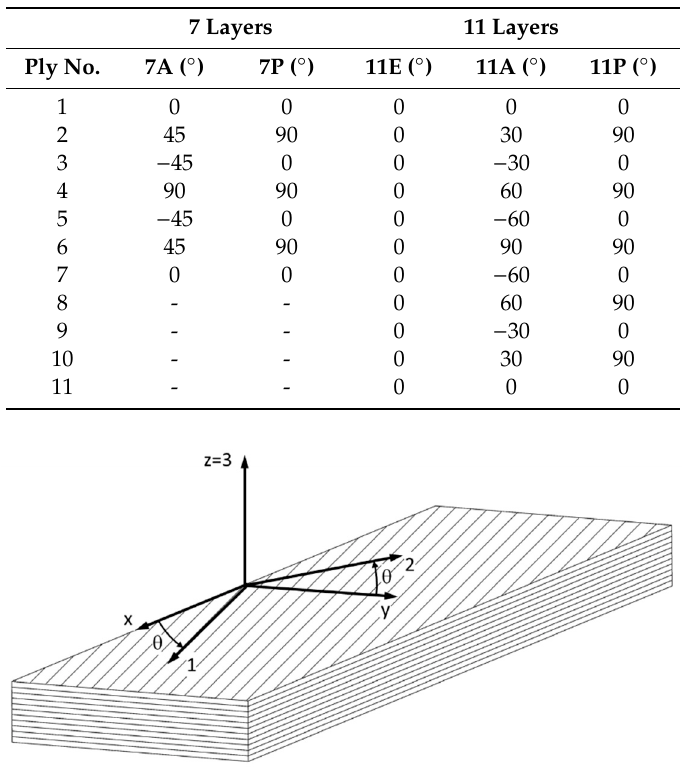
Figure 2. Plywood with specimen coordinate system ( x - y - z ) and principal material coordinate system (1-2-3), rotated by an angle θ .